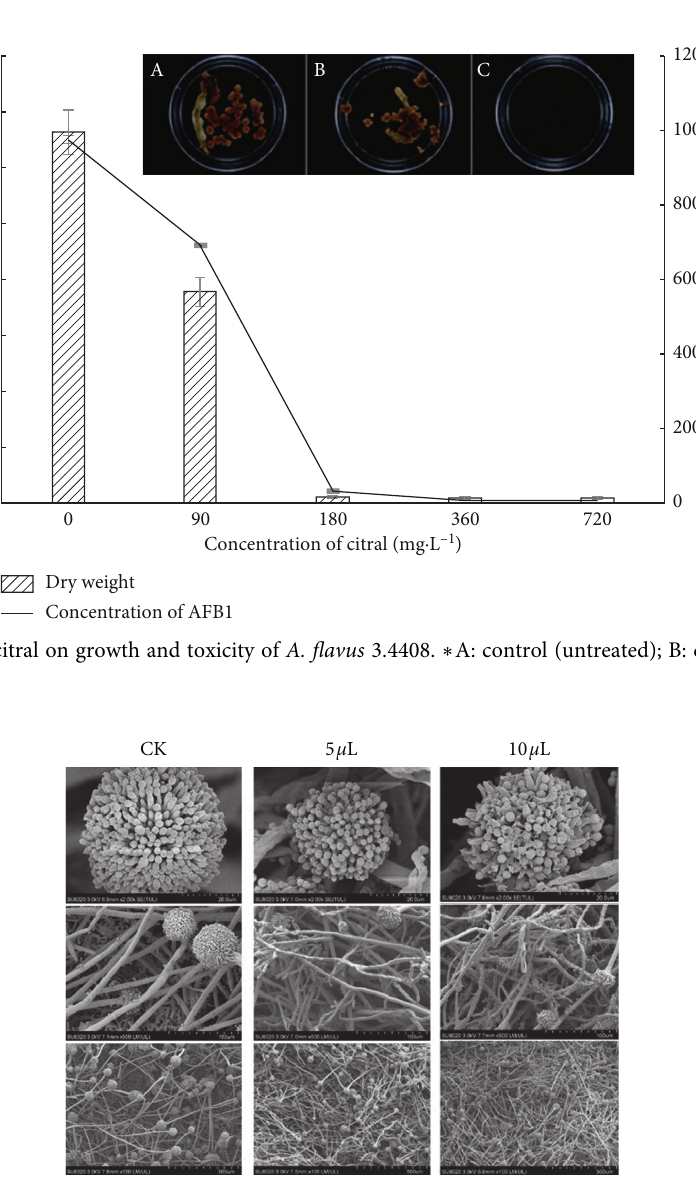
Figure 4: SEM of A. flavus